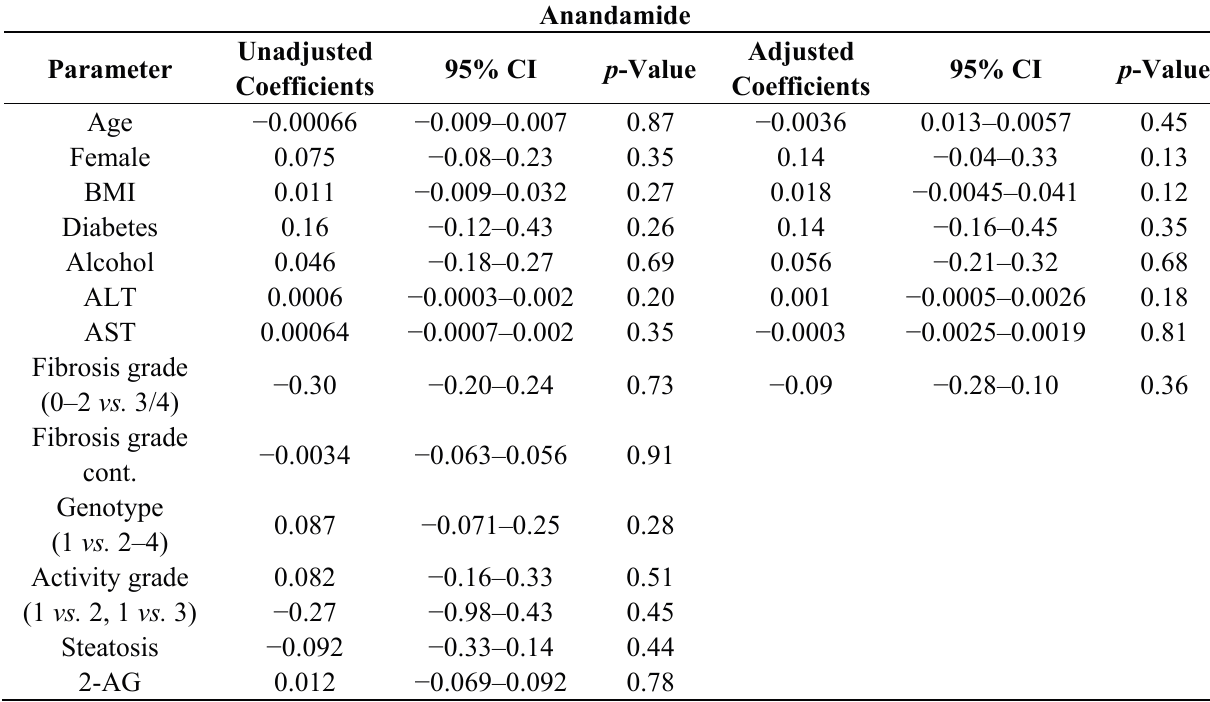
Table 1. Predictors of high endocannabinoids among hepatitis C virus (HCV) patients.